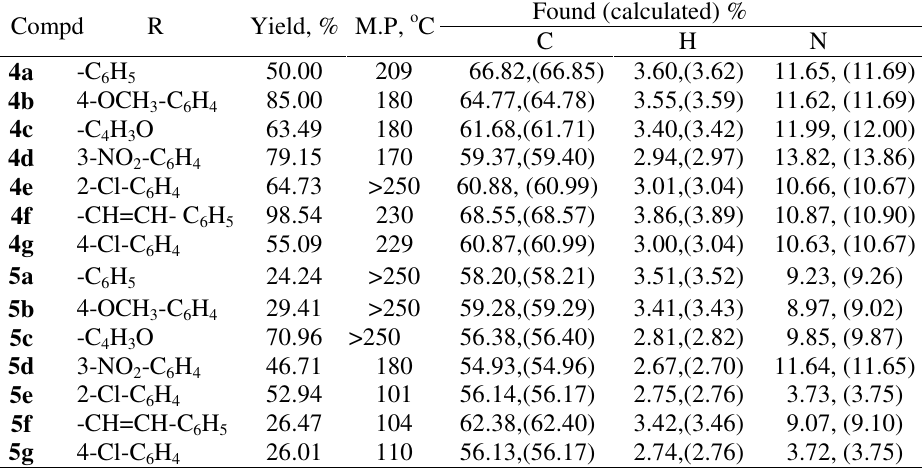
Table 1. The physical and analytical data of the newly synthesised compounds